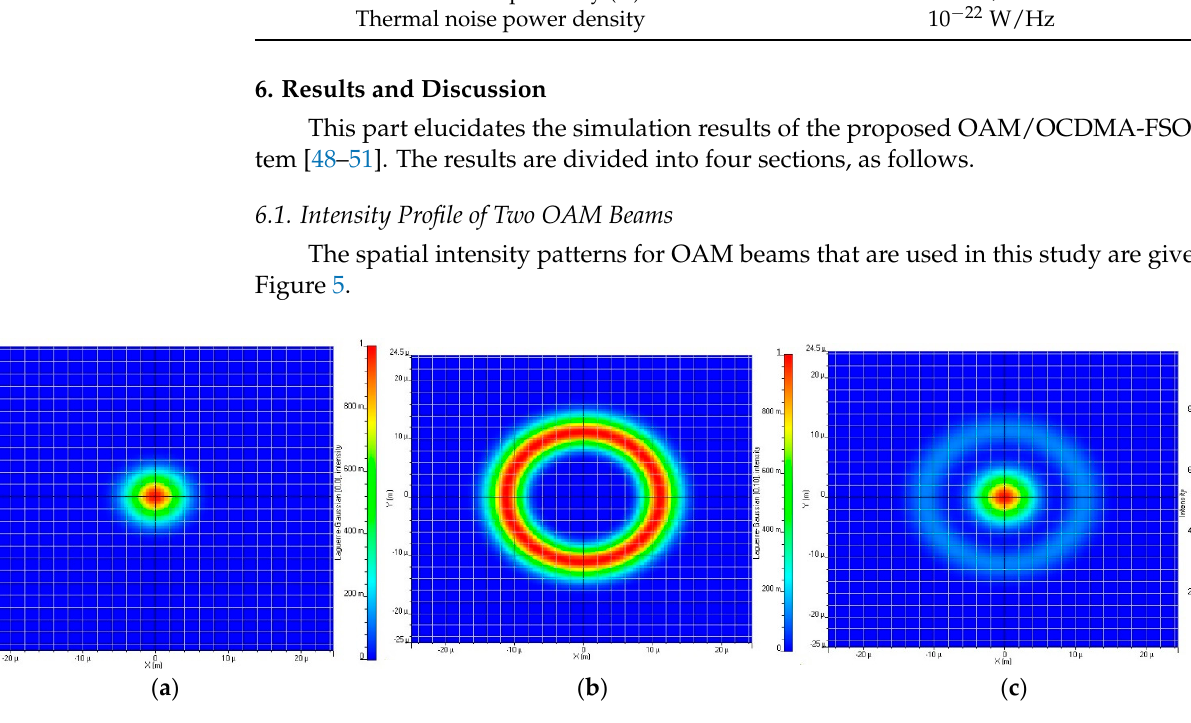
Figure 5. Spatial intensity profiles: ( a ) 𝐿𝐺 (cid:2868),(cid:2868) ; ( b ) 𝐿𝐺 (cid:2868),(cid:2869)(cid:2868) ; ( c ) multiplexed mode.